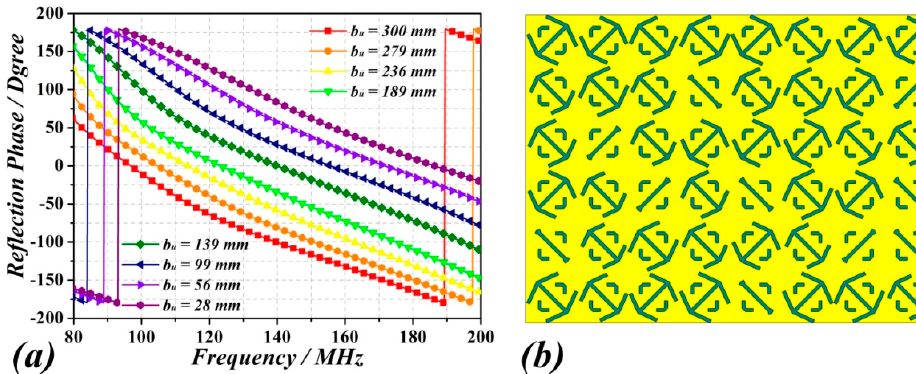
Figure 5. ( a ) Reflection phase response curves for the unit cell with different value of b u . ( b ) Layout of the 3-bit random coding metasurface. Some cells have been rotated to further enhance the field uniformity.